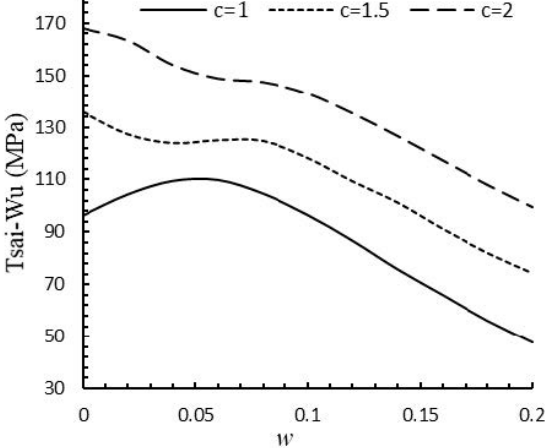
Figure 21. Strength variations of the graphite/epoxy with w in different values of c (Uniaxial tensile loading).